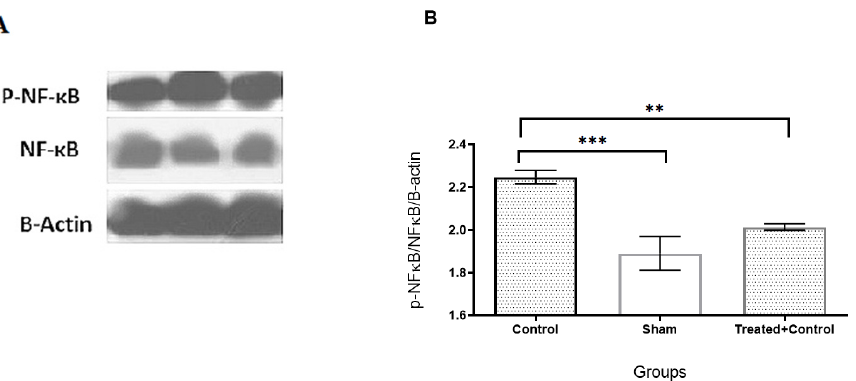
Figure 3. ( A ). Western blot of NF- κ B phosphorylation in brain tissues of groups. ( B ). IFD pre- treatment reduced phosphorylation of NF- κ B in animals 24 h after reperfusion. Data are shown as mean ± SEM. ** p < 0.01, *** p < 0.001.